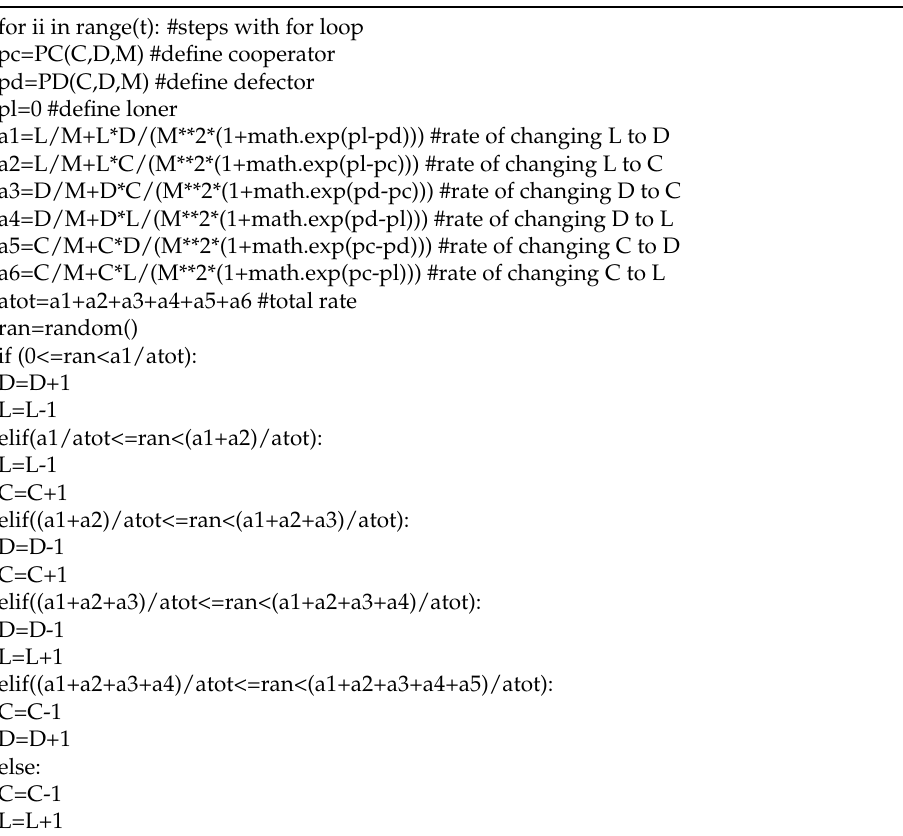
Table 5. Code book; applied Gillespie algorithm.